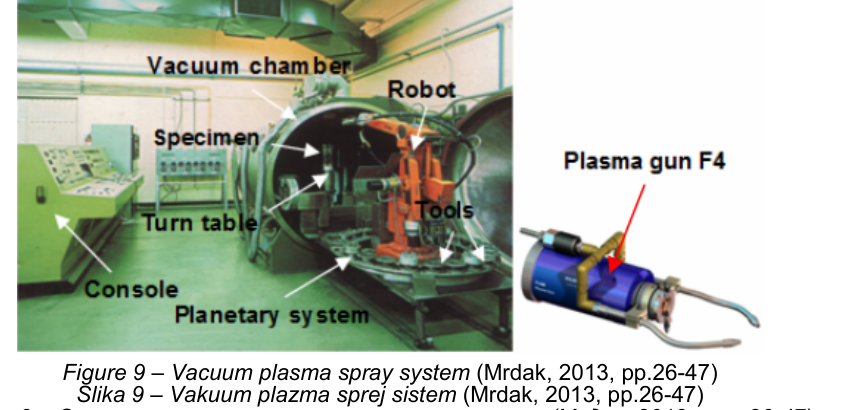
Рис . 9 – Система вакуумного плазменного нанесения ( Мрдак , 2013, стр